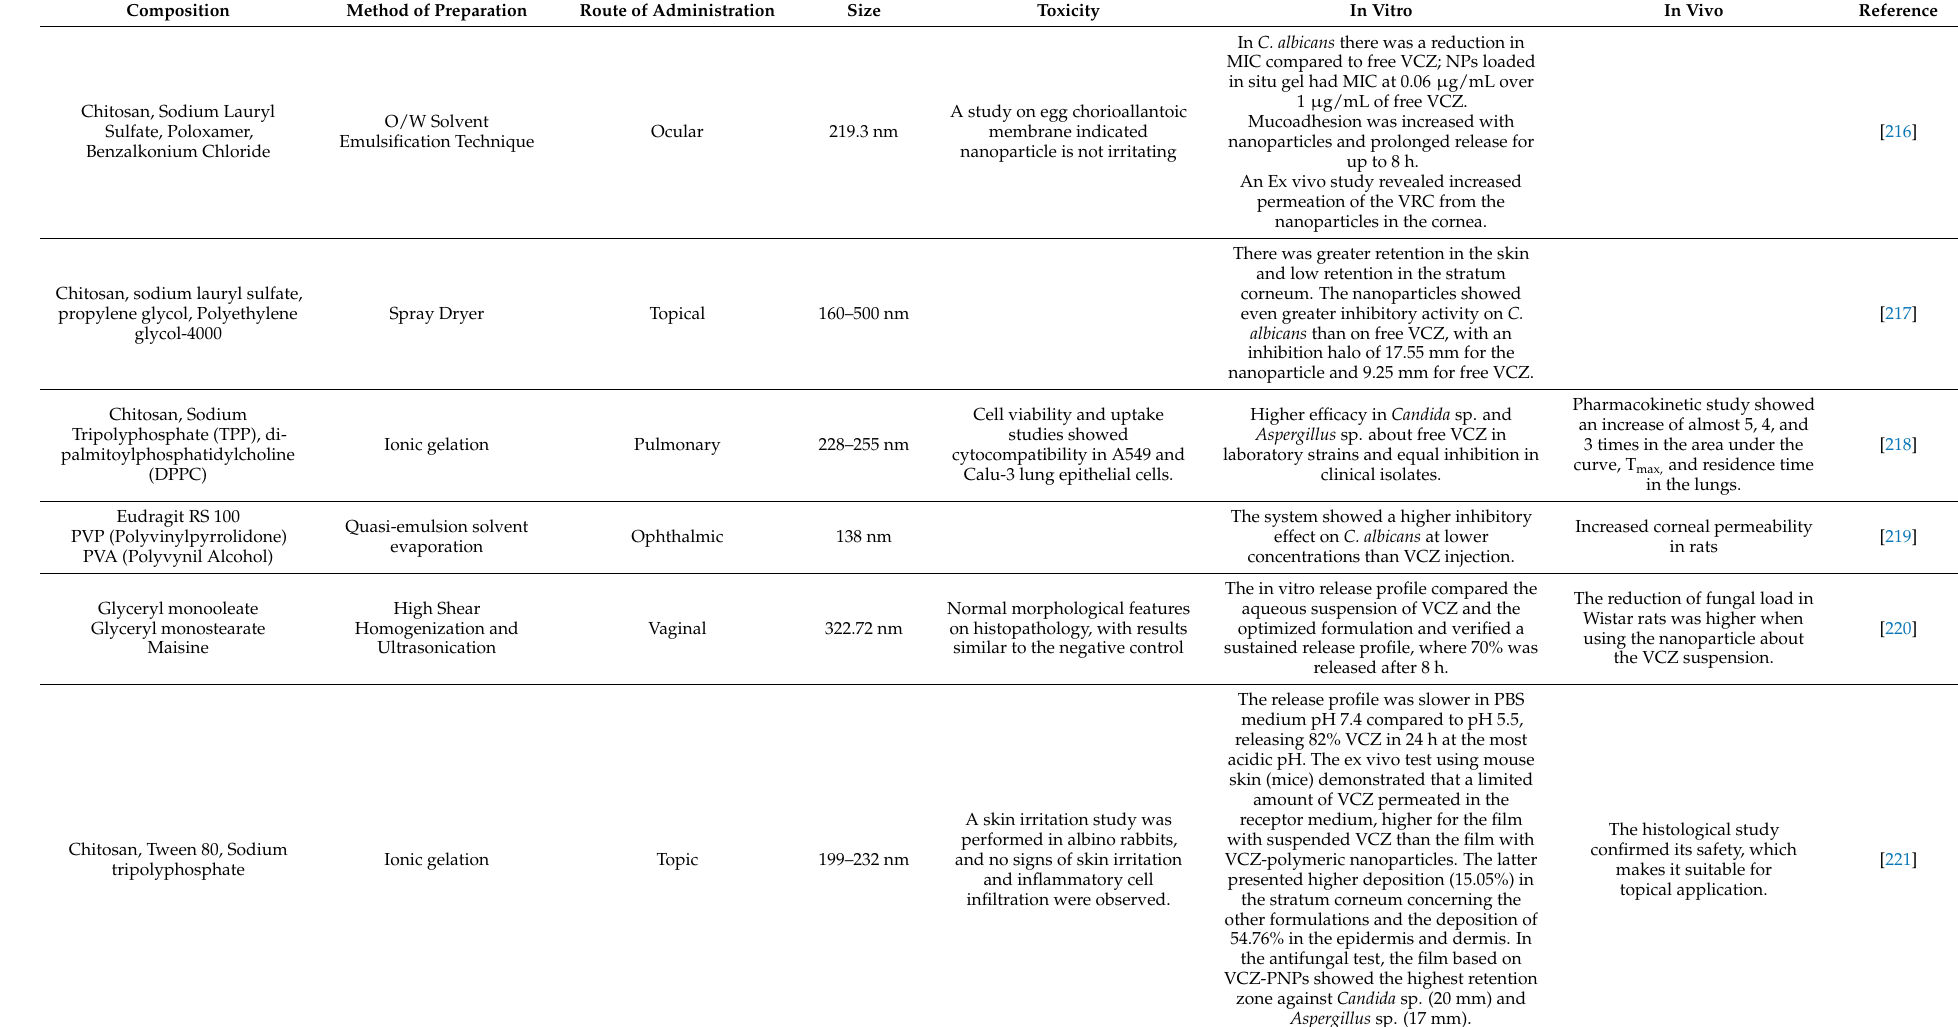
Table 2. Some aspects of studies on nanoformulations containing voriconazole in recent